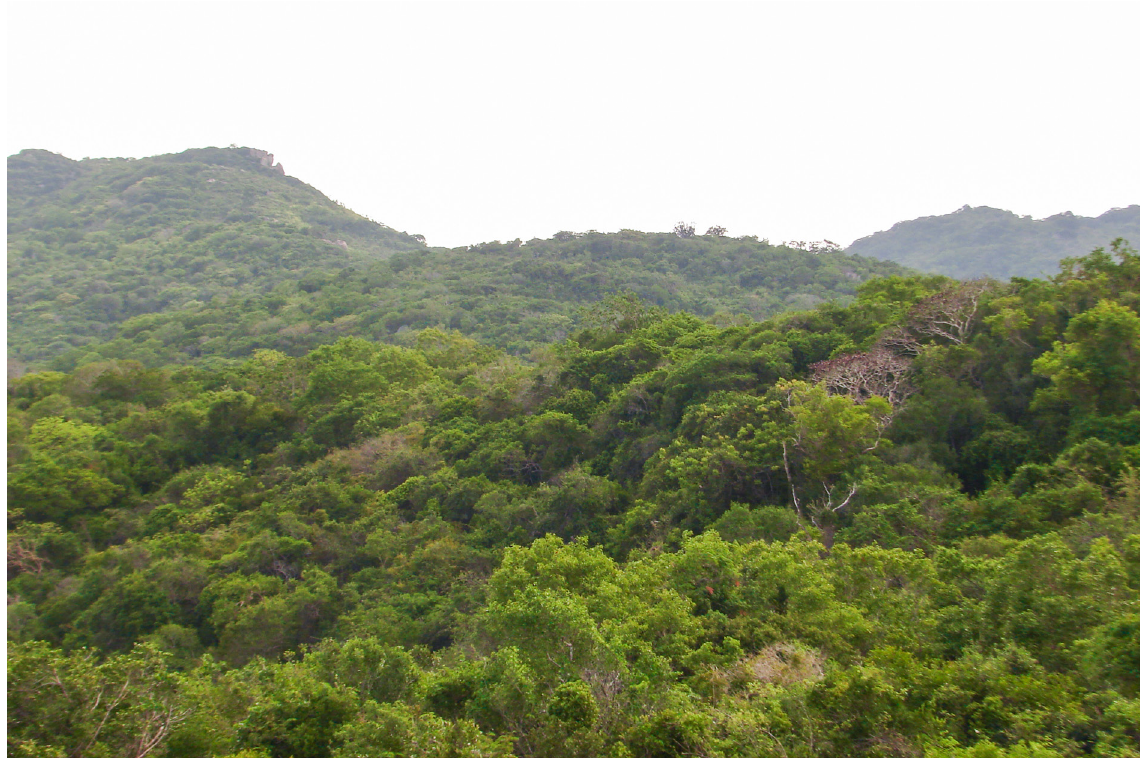
Fig. 7. Panoramic view of the disturbed secondary rainforest at the collection site in Núi Chúa